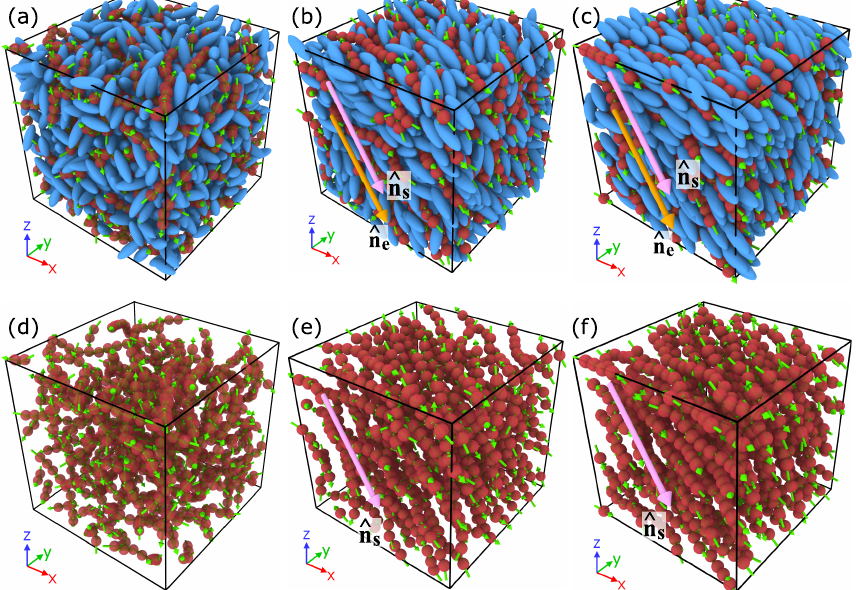
Figure 3. Snapshots of the LC–DSS mixture at densities ρ ∗ = 0.36 (panel ( a )), ρ ∗ = 0.46 (panel ( b )), and ρ ∗ = 0.58 (panel ( c )). Blue ellipsoids represent the LCs, red spheres denote the DSS Panels and green arrows indicate the direction of the dipole moment. Panels ( d – f ) show the DSS in the absence of the LCs. The orange and pink arrows represent the directors ˆ n e and ˆ n s . All snapshots were prepared using the package OVITO [59].